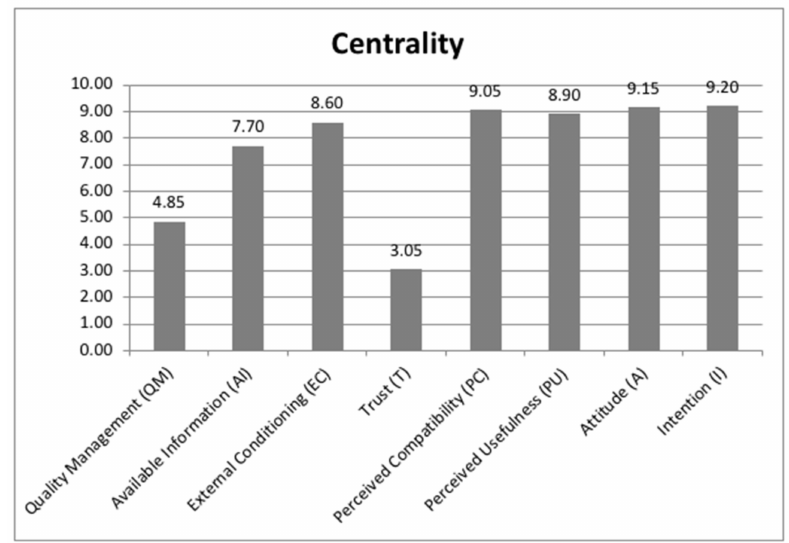
Figure 3. Indicators of the fuzzy cognitive map: